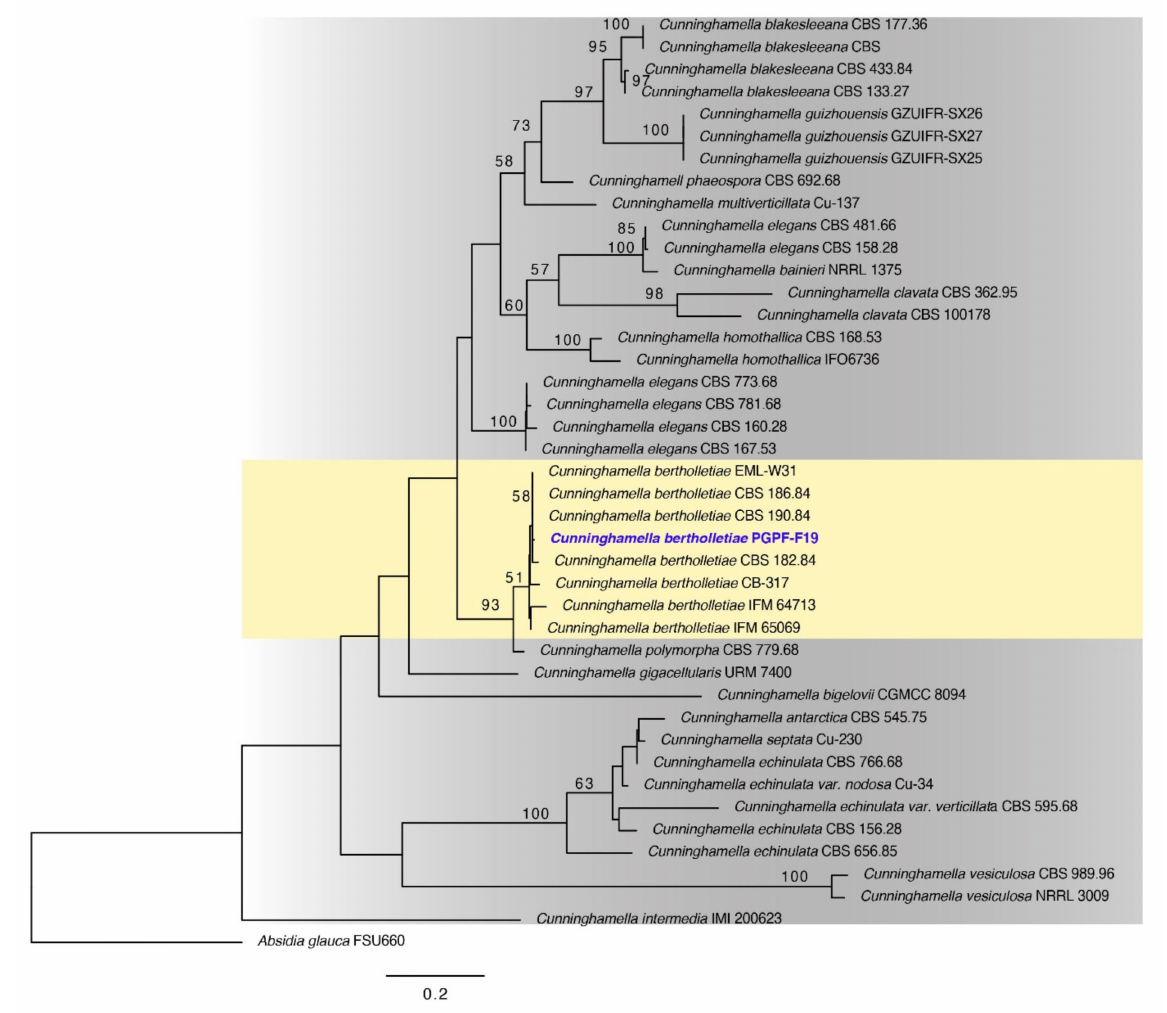
Figure 1. Maximum likelihood tree obtained from the ITS sequence alignment analysis of the species in section Cunninghamella . Bootstrap values (>50) are represented by numbers at the nodes based on 1000 replications. The strain in blue font is from our